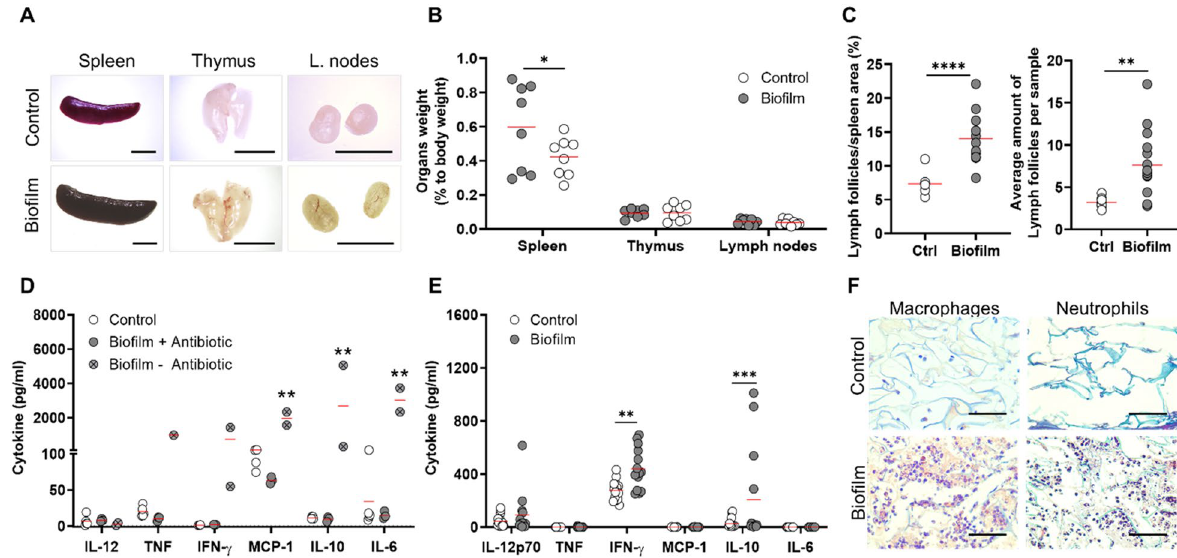
Figure 7. Systemic and local inflammatory response of mice towards biofilm-containing scaffolds. ( A ) Representative images of immune organs show increased size of spleen due to biofilm implantation. ( B ) Organs weight relative to total body weight of mice show a significant increase of spleen due to biofilm infection, whereas thymus and lymph nodes show no differences. ( C ) Morphometrical analysis of spleen slices stained with H&E to quantify are of lymph follicles per spleen area and average number of lymph follicles per sample. ( D ) Plasma samples from mice implanted with sterile scaffolds (Control), with biofilm containing scaffolds and ciprofloxacin systemic treatment (Biofilm + antibiotic) or no antibiotics (Biofilm – antibiotic) were analyzed for pro-inflammatory cytokine quantitation. Only animals with infected scaffolds and no systemic treatment had significantly higher cytokine levels. ( E ) Protein extracts from the implanted scaffolds were analyzed, showing higher levels of IFN-γ and IL-10 due to biofilm infection. ( F ) Histological sections from biofilm- containing or control scaffolds after implantation were processed for immunohistochemistry with CD68 antibody (macrophages) and Masson’s trichrome stain (neutrophils). Representative images show infiltration of macrophages and PMN cells in presence of biofilm. Scale bar for A represents 5 mm; for F represents 60 µm. Individual values and mean (red line) are plotted. Two-way ANOVA and Sidak’s multiple comparison test for B and E; Mann–Whitney test for C; and two-way ANOVA and Tukey’s posteriori comparison for D. *p < 0.05; **p < 0.01; ****p < To identify bacterial species in the scaffolds, MALDI-TOF MS (Matrix-assisted laser desorption/ionization time of flight mass spectrometry) analysis was performed (Supplementary Fig. S3), showing the predominance of P. aeruginosa in 90% of samples before and after 10 days of implantation, 10% of samples had E. faecalis and 10% had S. aureus . Also, several other bacterial genera that were not initially inoculated were found in colonized wounds, but they were specific for each specific wound, where 20% of samples had Kocuria rosea , 10% had Escherichia coli , 10% had Pseudarthrobacter sulfonivorans and 10% had Pseudomonas straminea , showing a total of seven bacterial species detected in biofilm-containing scaffolds from this study (data not shown). Systemic and local inflammation process induced by local infection. After confirming a local infection response provoked by the biofilm implantation in wounds, their effect over the systemic inflamma- tion process was characterized (Fig. 7). For systemic inflammation analysis, blood and lymphoid organs were extracted. Increased size of the spleen was observed due to biofilm implantation (Fig. 7A), which was confirmed with a significant increase in its weight, compared to the control group (Fig. 7B). Lymph nodes and thymus did not show variations in size nor weight under biofilm infection (Fig. 7A,B). The microscopic inspection of spleen histological slides stained with H&E showed an increase in the ratio of lymph follicles/spleen area and the aver- age amount of lymph follicles in the biofilm-infected groups (Fig. 7C). To quantify systemic pro-inflammatory cytokines, blood was extracted from implanted animals, and plasma fraction was analyzed by flow cytometry (Fig. 7D). None of the cytokines measured showed significant variations between groups treated with ciprofloxacin (control or biofilm-infected groups). In contrast, cytokine levels from animals with biofilm-containing scaffolds that were not treated with antibiotics, and suffered septicemia, showed elevated levels for cytokines MCP-1 (monocyte chemoattractant protein-1), IL-10 and IL-6 compared to groups treated with ciprofloxacin and control (Suppl. Fig. S2). Once the systemic inflammatory response was evaluated, the local inflammatory process was also studied (Fig. 7E,F). Here cytokines obtained from protein extracts of the implanted scaffolds were quantified, showing significantly higher levels of IFN-γ and IL-10 in infected samples compared to sterile ones (Fig. 7E). To evaluate leukocyte infiltration, histological sections from scaffolds were processed for immunohistochemical and histo- chemical analysis to detect macrophages and neutrophils (Fig. 7F). Results show that in the presence of biofilm